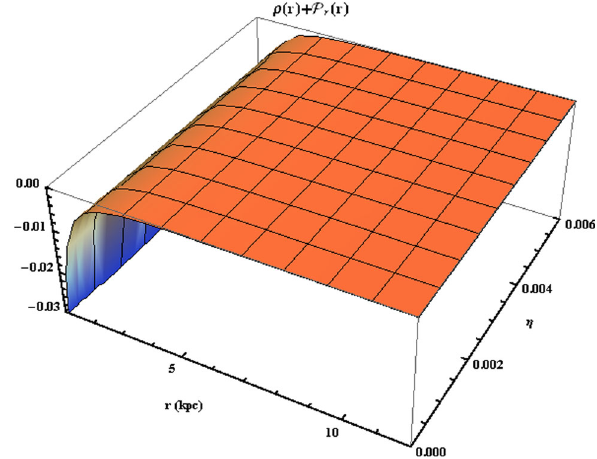
Fig. 11 ρ( r ) + P r ( r ) is plotted with respect to the radial coordinate r corresponding to the parameters ρ 0 = 0 . 004 kpc − 2 , α = 0 . 5 , β = 0 . 8 , r th = 1 kpc , C = 0 . 05 , j = 1 , k = 1 , δ = 0 . 1 , γ = 0 . 001 and r 0 = 2